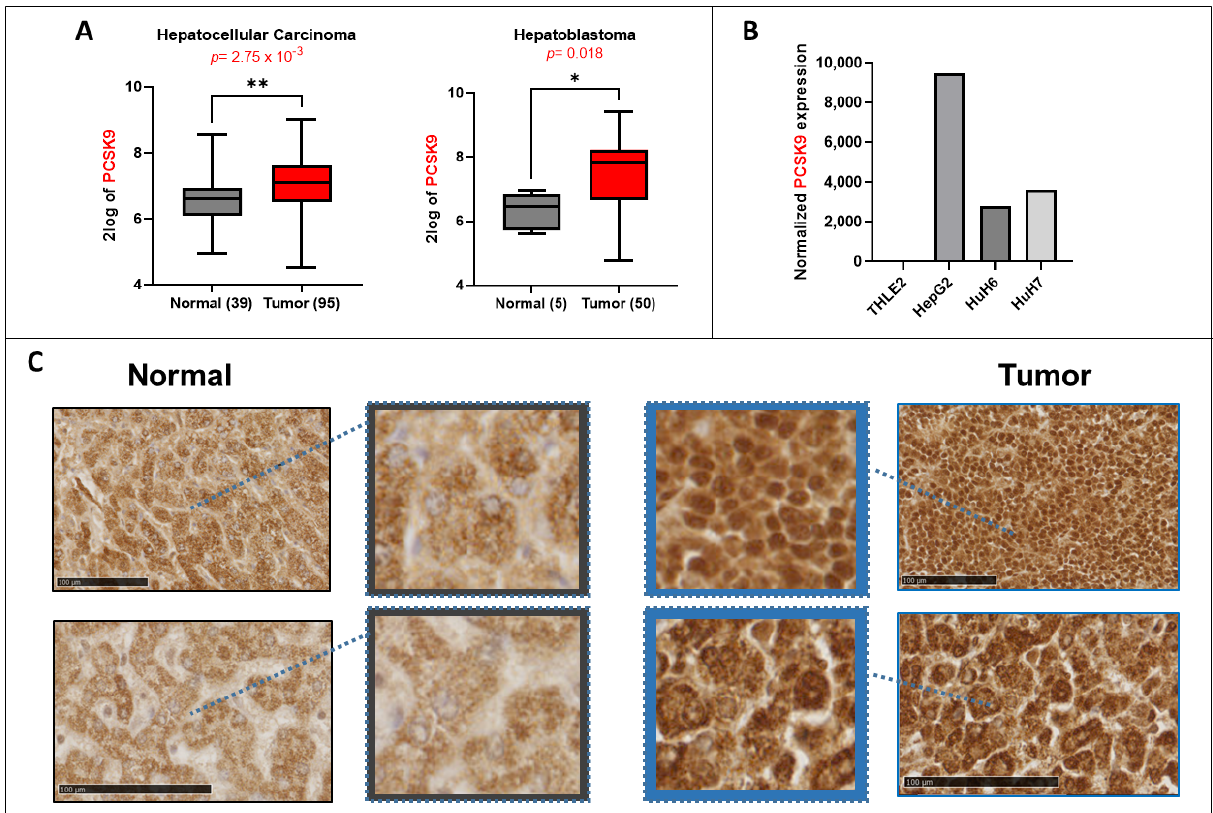
Figure 1. Lipid metabolism in liver cancer. ( A ) PCSK9 gene expression